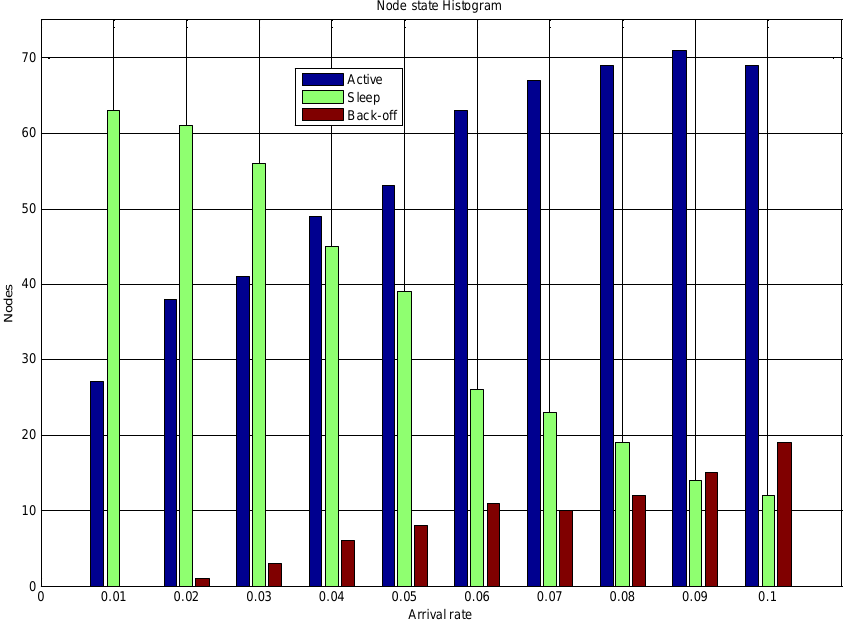
Figure 17. EEMACCSN node state behaviour vs. arrival rate.